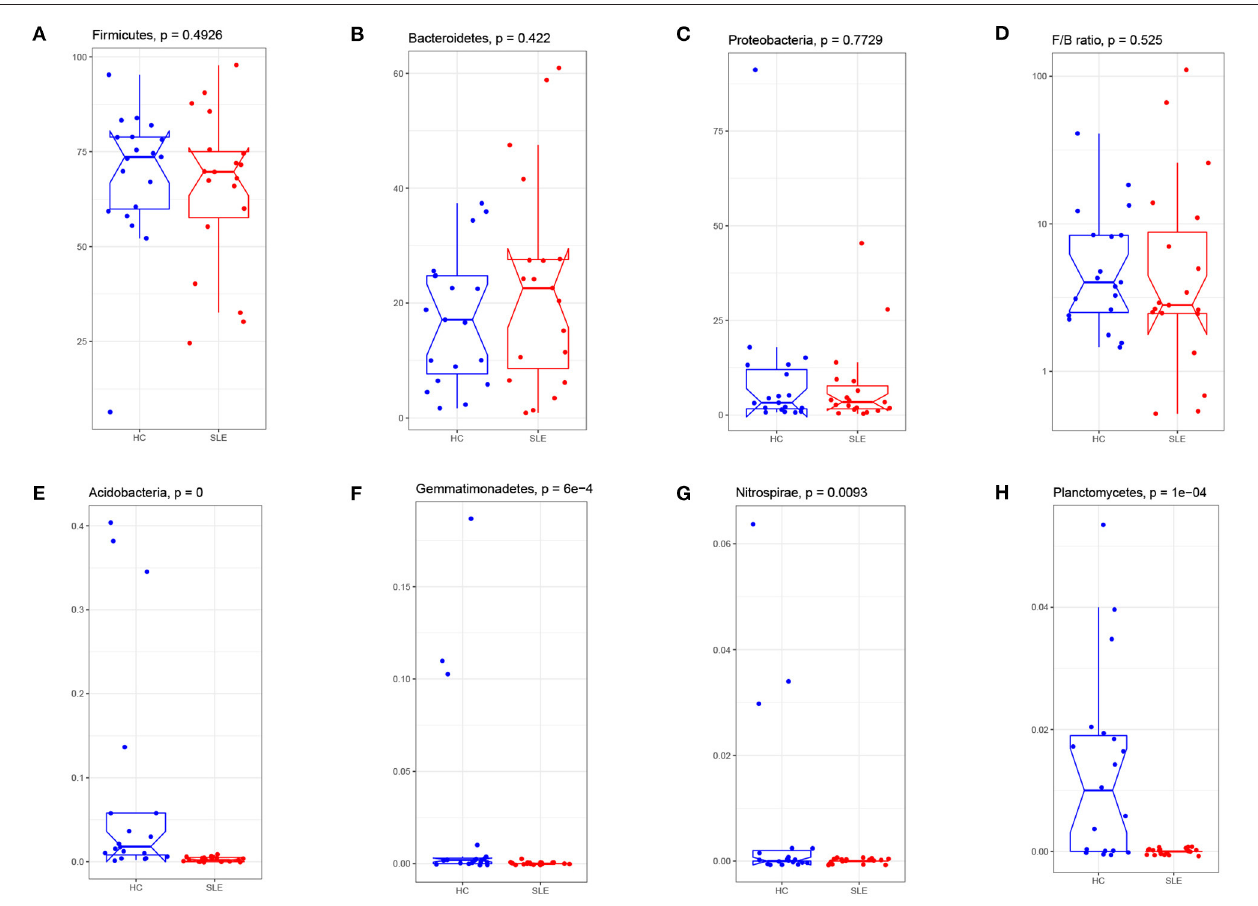
FIGURE 3 | Phylum abundance comparison of gut microbiota between the SLE and HC groups. Three major phyla: the Firmicute (A) , Bacteroides (B) , Proteobacteria (C) , and were compared and the ratio of Firmicute/Bacteroides (D) were plotted. The percentage of Acidobacterium (E) , Gemmatimonadetes (F) , Nitrospirae (G) , and Planctomycetes (H) in SLE fecal were significantly reduced after FDR adjustment (q < 0.05). F/B: the relative abundance of Firmicute to